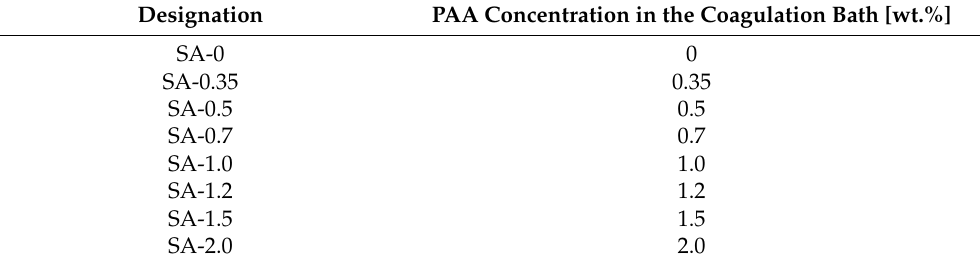
Table 1. Designations of PSF/Synperonic F108 membranes prepared using different PAA concentra- tions in the coagulation